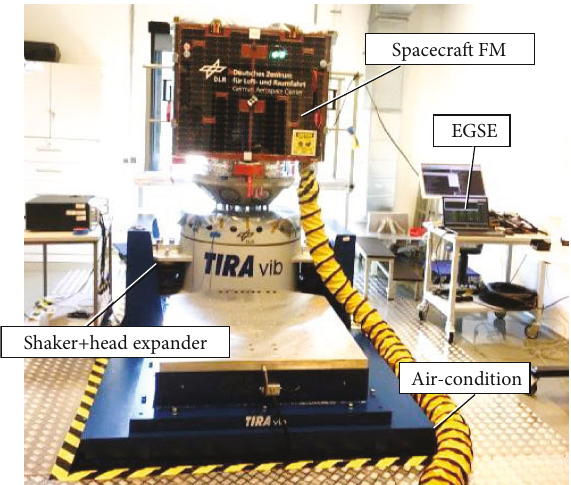
Figure 13: Spacecraft FM during vibration acceptance functional